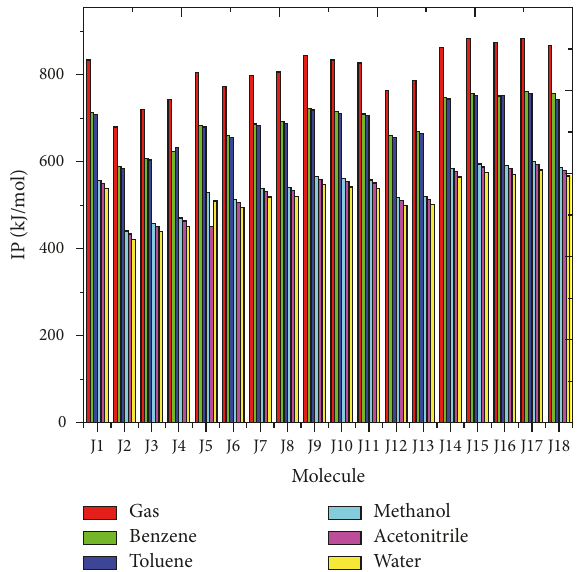
Figure 5: Ionization potentials of J 𝑛 (in kJ/mol) at B3LYP/6- 31+G(d,p) level in various